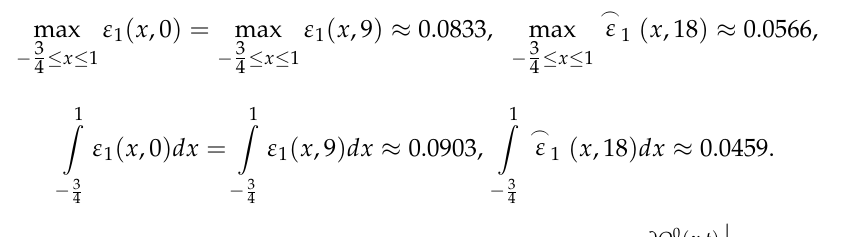
Figure 2. The solid line denotes Q 0